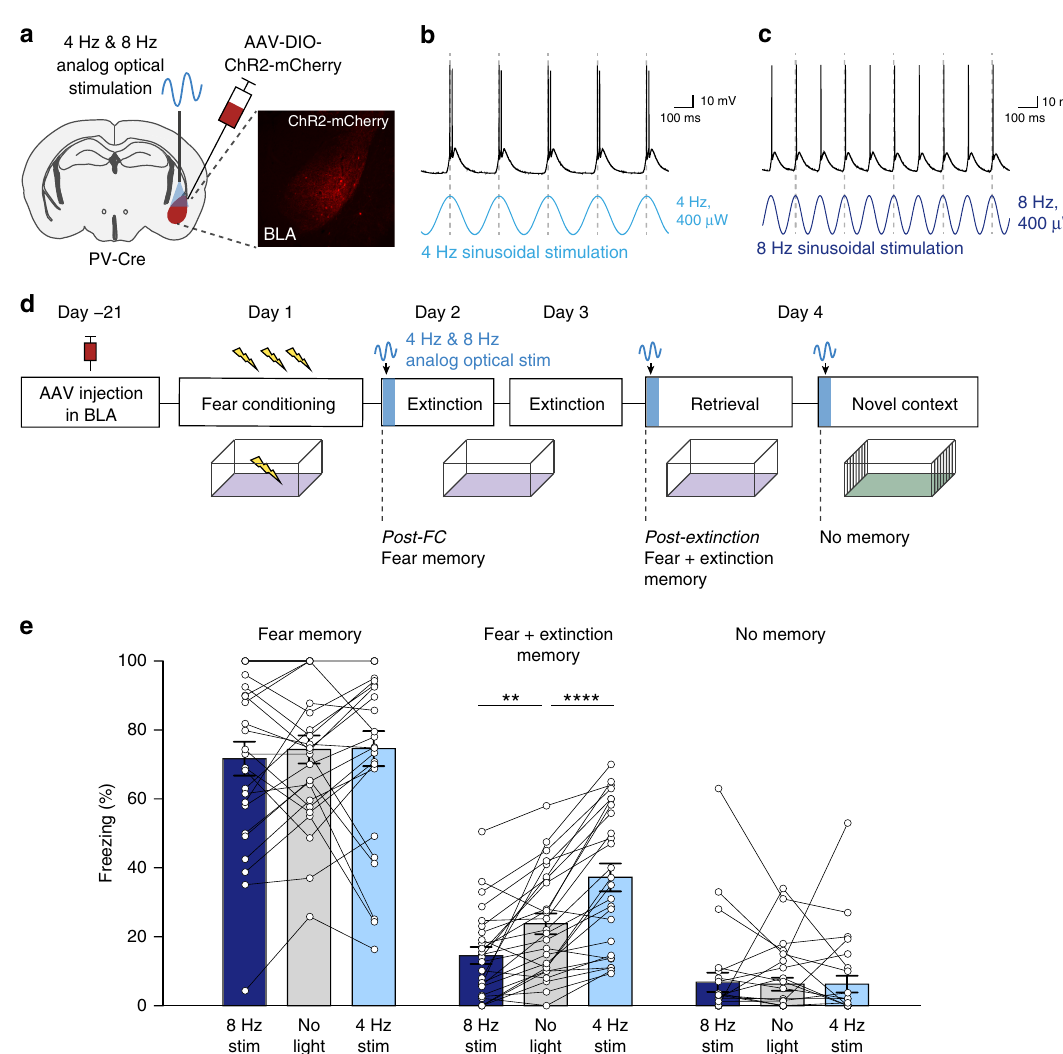
Fig. 2 Frequency-based, bidirectional control of post-extinction memory retrieval. a Schematic of viral strategy for in vivo optogenetic control of BLA PV- interneurons. b , c Example traces from acute BLA slices demonstrating effect of sinusoidal optical stimulation on action potential generation in PV- interneurons (also see Supplementary Fig. 2). d Schematic of experimental design for standard extinction group (see Supplementary Fig. 3a for experimental design for delayed extinction group; see Methods section for details). e Optical stimulation of BLA PV-interneurons has a bidirectional effect on memory retrieval in the conditioned context following, but not before, extinction learning (two-way repeated measures ANOVA: trial F (2,50) = 134.4, P < 0.0001, stimulation F (2,50) = 18.49, P < 0.0001, trial × stimulation F (4, 100) = 10.15, P < 0.0001, n = 26 mice; Holm – Sidak ’ s multiple comparisons test; fear memory: no light vs. 8 Hz stim t (100) = 0.94, P = 0.57; no light vs 4 Hz stim t (100) = 0.09, P = 0.93; fear + ext memory: no light vs 8 Hz stim t (100) = 3.27, P = 0.0015; no light vs 4 Hz stim t (100) = 4.8, P < 0.0001; no memory: no light vs 8 Hz stim t (100) = 0.21, P = 0.97; no light vs 4 Hz stim t (100) = 0.018, P = 0.99). Error bars: mean ± (Supplementary Fig. 1l). Interestingly, the populations of neurons properties during endogenous oscillatory activity. Units that were